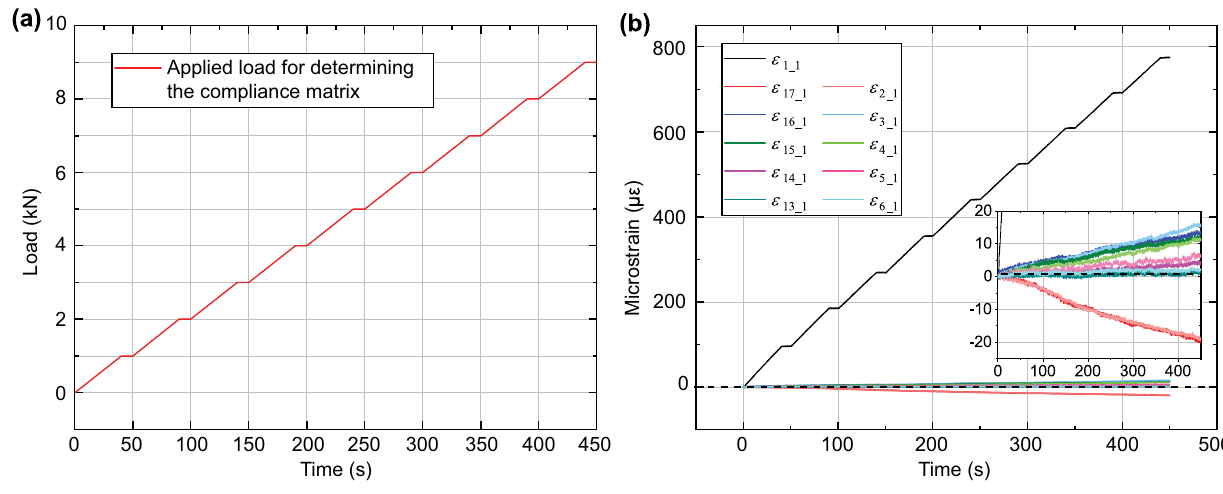
Fig. 6 a The real-time applied load during the calibration matrix test and b strain signals from the test when the test point No. 1 is loaded